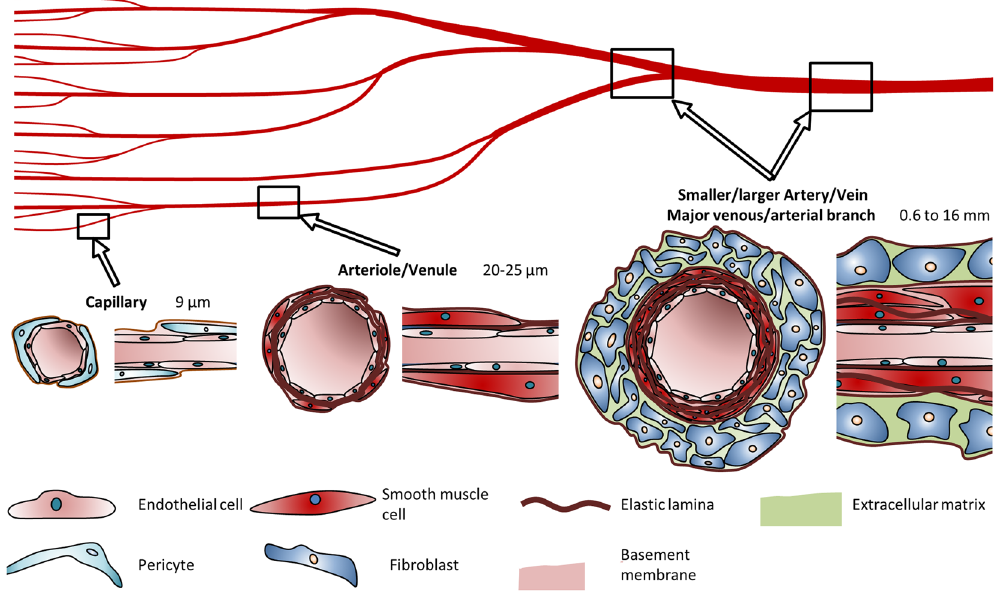
Figure 1. Cell types and composition of vascular channels and their typical diameters. Capillaries comprise a typical EC lining surrounded by pericytes. Arterioles/venules are surrounded by a small number of SMCs. Arteries and veins consist of a dense SMC layer, which is enclosed by